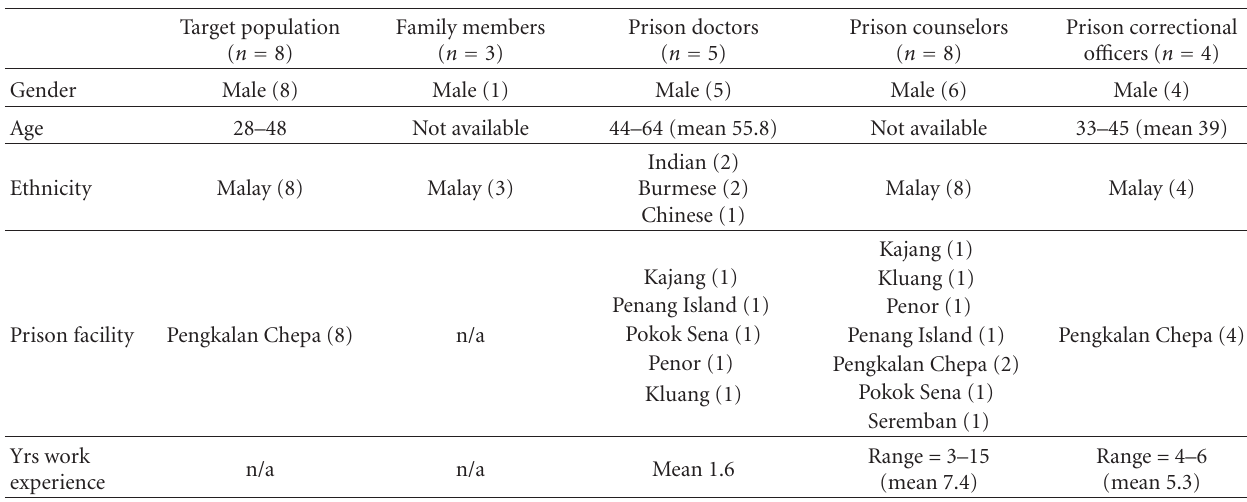
Table 3: Demographic characteristics of all interview